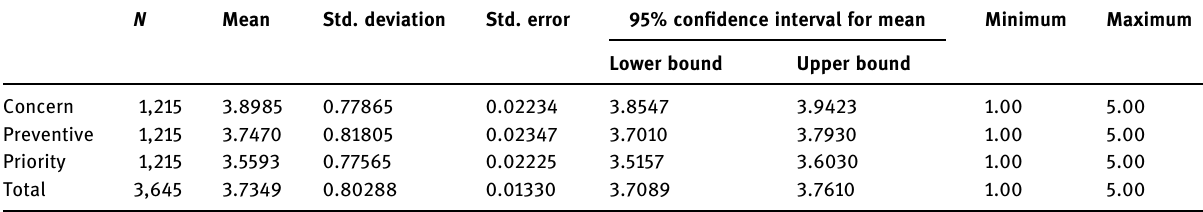
Table 17: Descriptive of awareness level by parents ’ job N